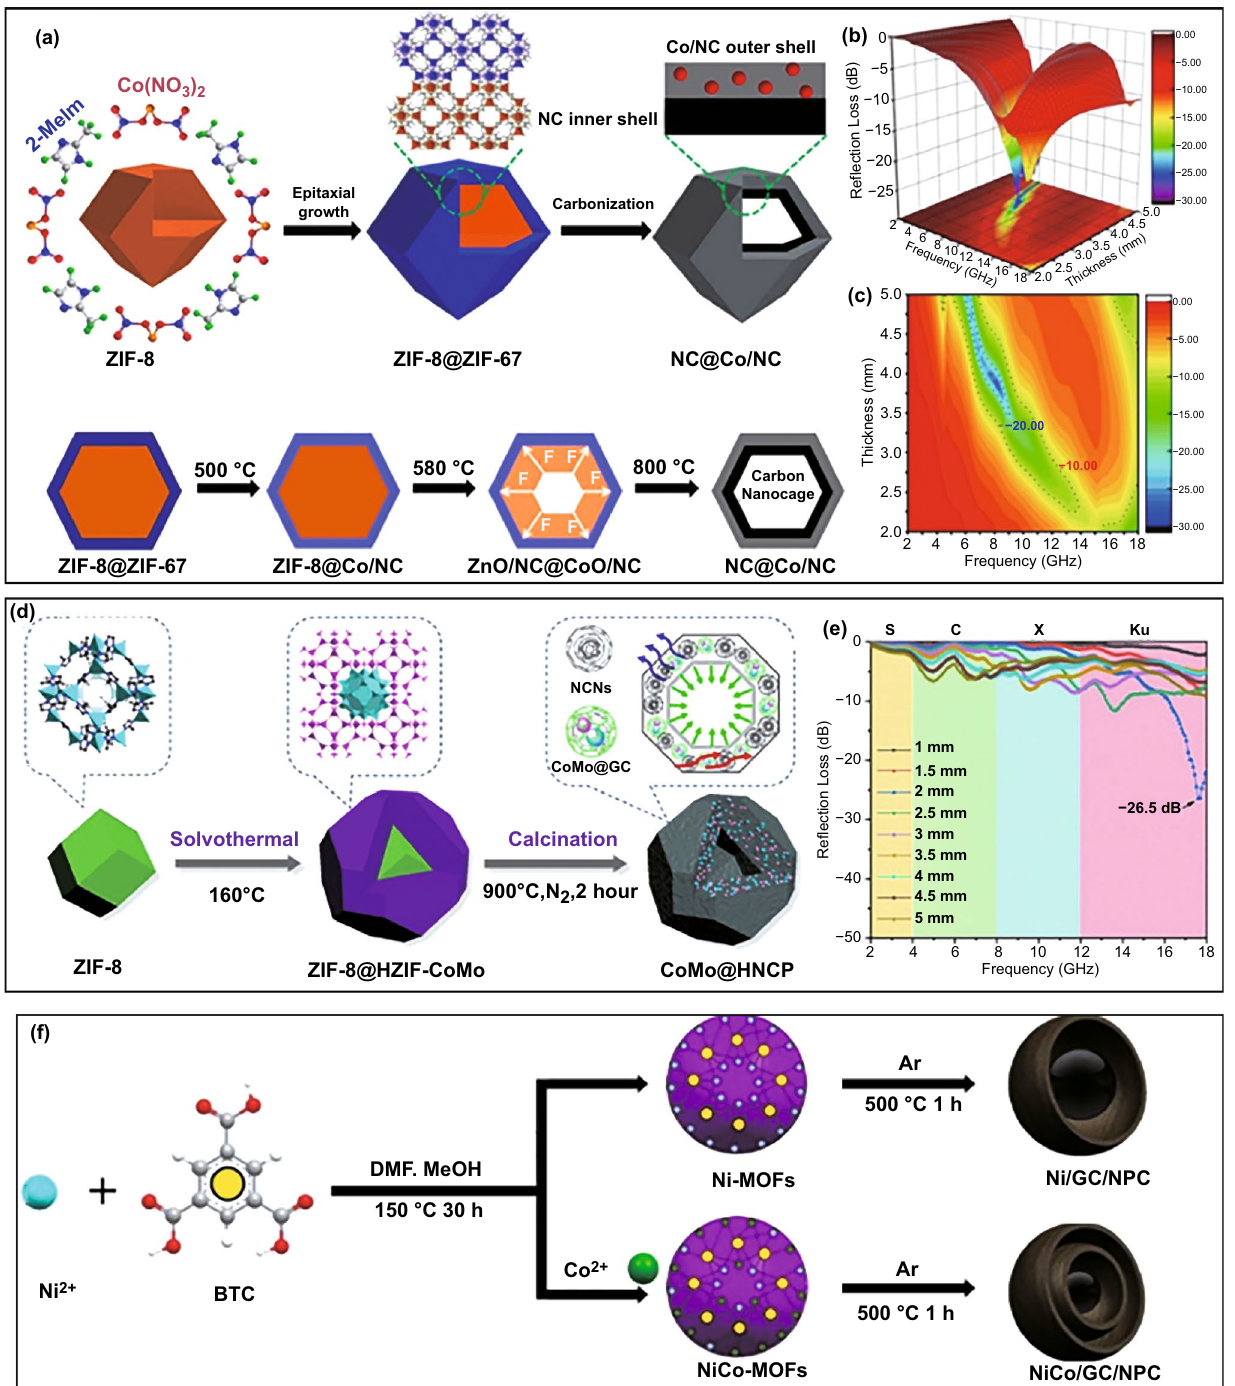
Fig. 12 a Schematic illustration for the formation process and the synthetic mechanism of NC@Co/NC carbon nanocages , b, c 3D RL map and RL map of NC@Co/NC carbon nanocages. Reproduced with permission from Ref. [179] . Copyright © 2020 Elsevier B.V. d Schematic illus- tration for the synthesis process of hollow CoMo@HNCP polyhedron , e RL values of CoMo@HNCP. Reproduced with permission from Ref. [178] . Copyright © 2020 Elsevier Ltd. f Schematic formation process of the composites . Reproduced with permission from Ref. [182] . Copy- right © 2020 Elsevier